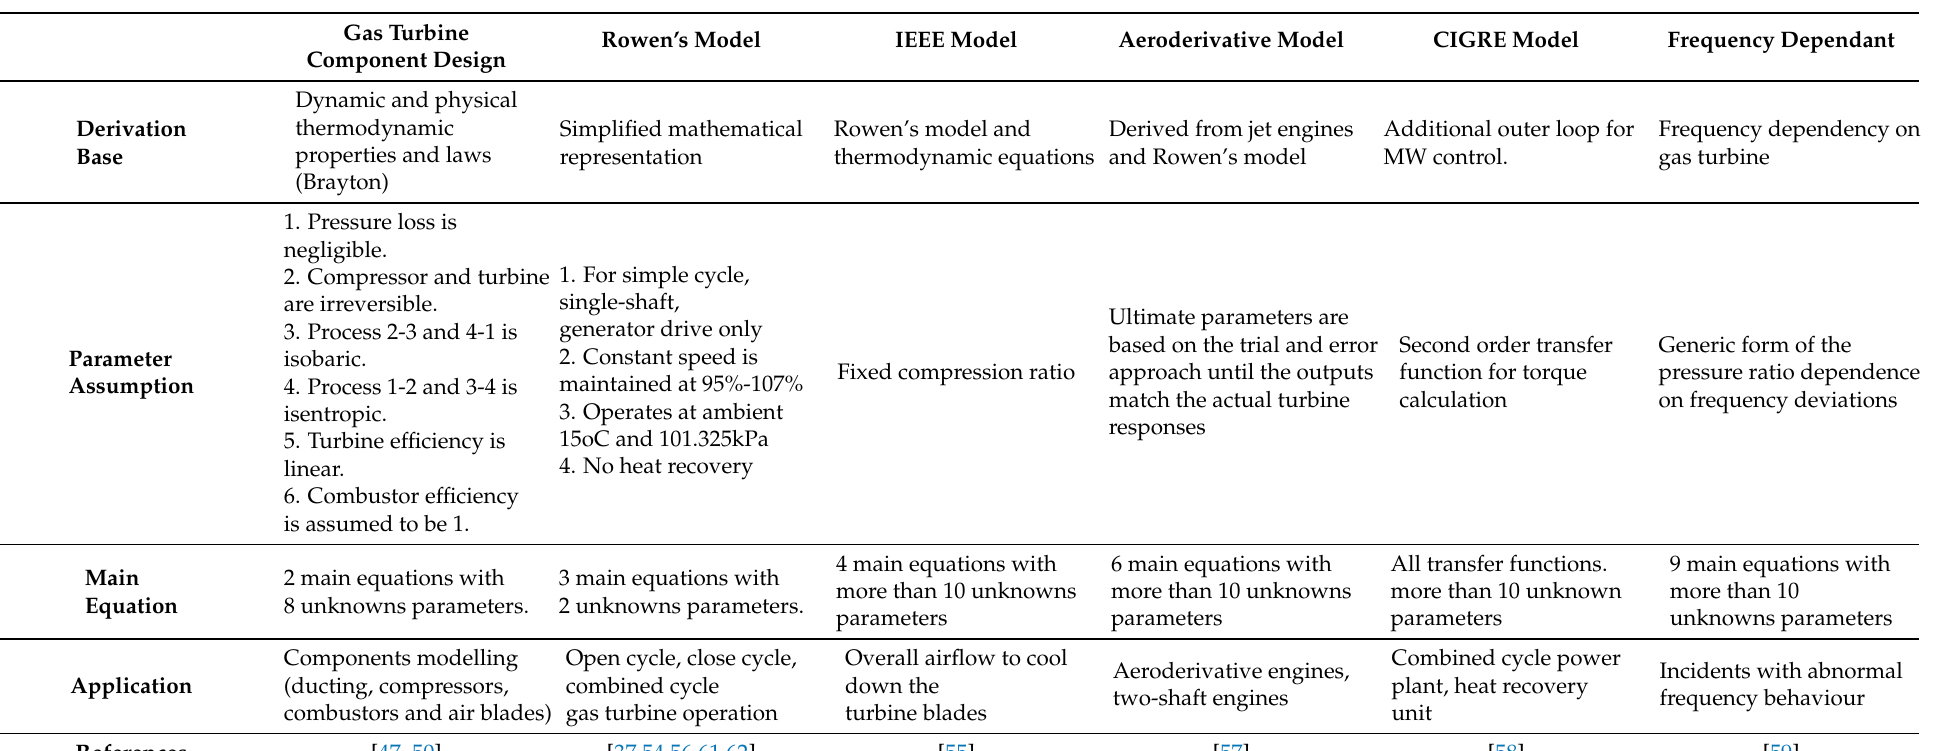
Table 2. Summary of gas turbine